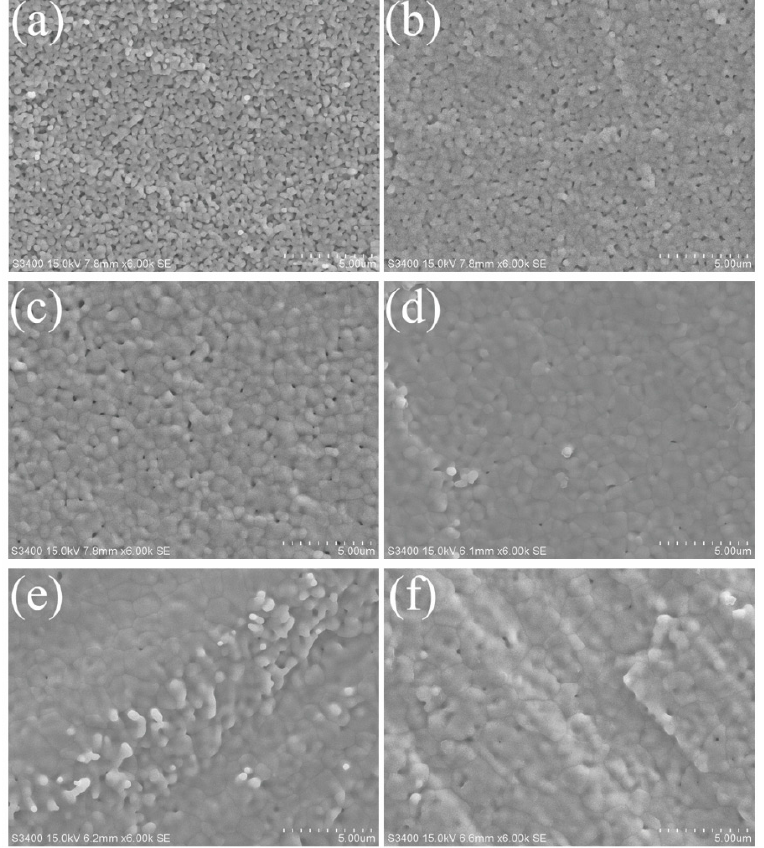
Figure 2. Scanning electron microscope (SEM) images of sintered Sc 0.1 Ce 0.05 Gd 0.05 Zr 0.89 O 2 (SCGZ) at ( a ) 1423 K, ( b ) 1473 K, ( c ) 1523 K, ( d ) 1573 K, ( e ) 1623 K, and ( f ) 1673